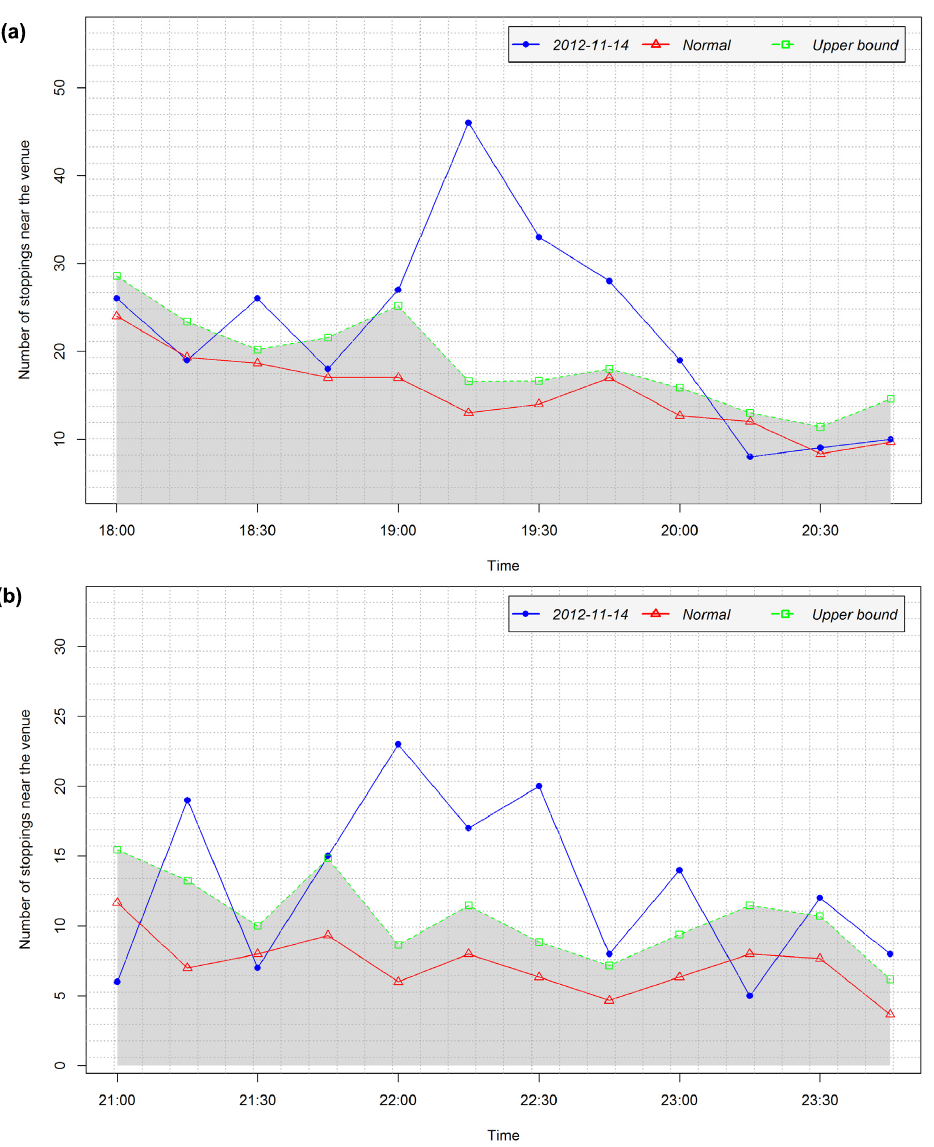
Figure 11. Temporal variation of P , Q , and UP during the period around ( a ) arrival time; and ( b ) departure time on 14 November